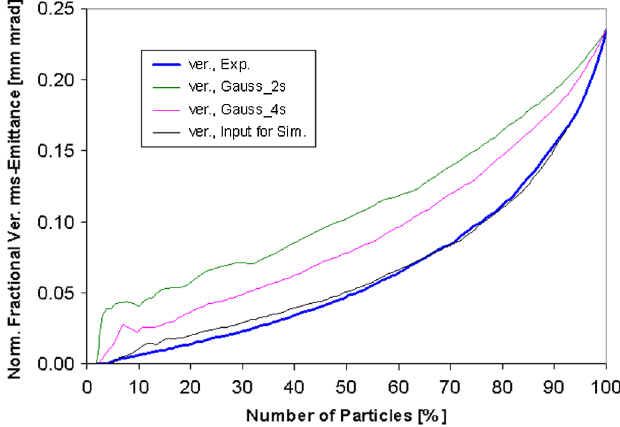
FIG. 8. (Color) Brilliance curves of the vertical phase space distribution in front of the DTL. The curves were extracted from the measured distribution (blue bold), a Gaussian cut at 2 (cid:4) (green), a Gaussian cut at 4 (cid:4) (pink), and from the distribu- tion used for the simulations